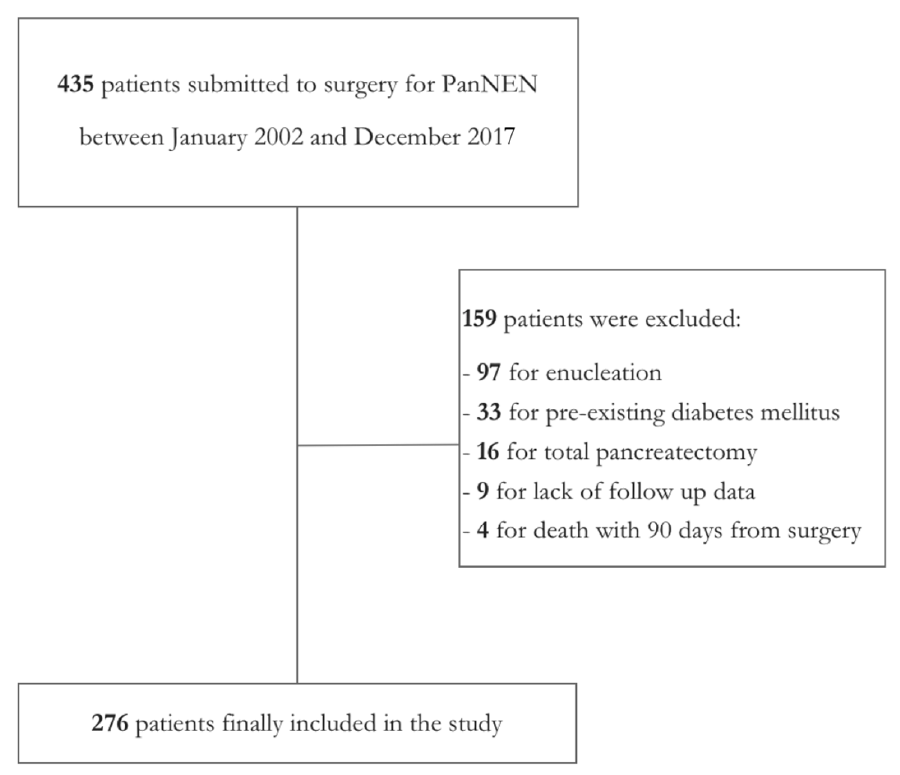
Figure 1. Flowchart representing patients included in the study.